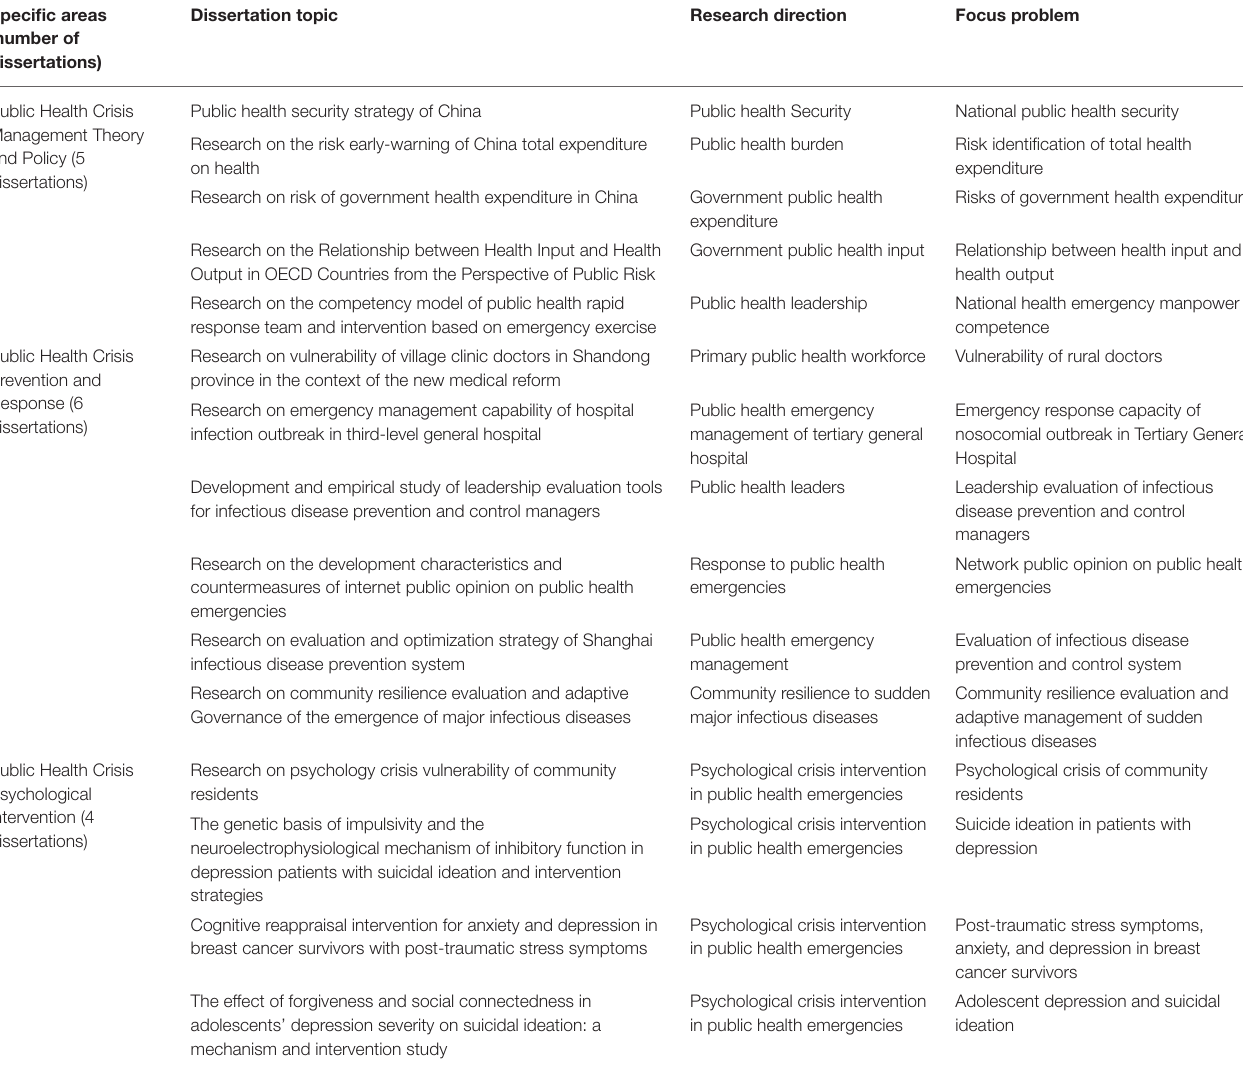
TABLE 2 | Scientific research of DrTP-PHCM. Specific areas (number